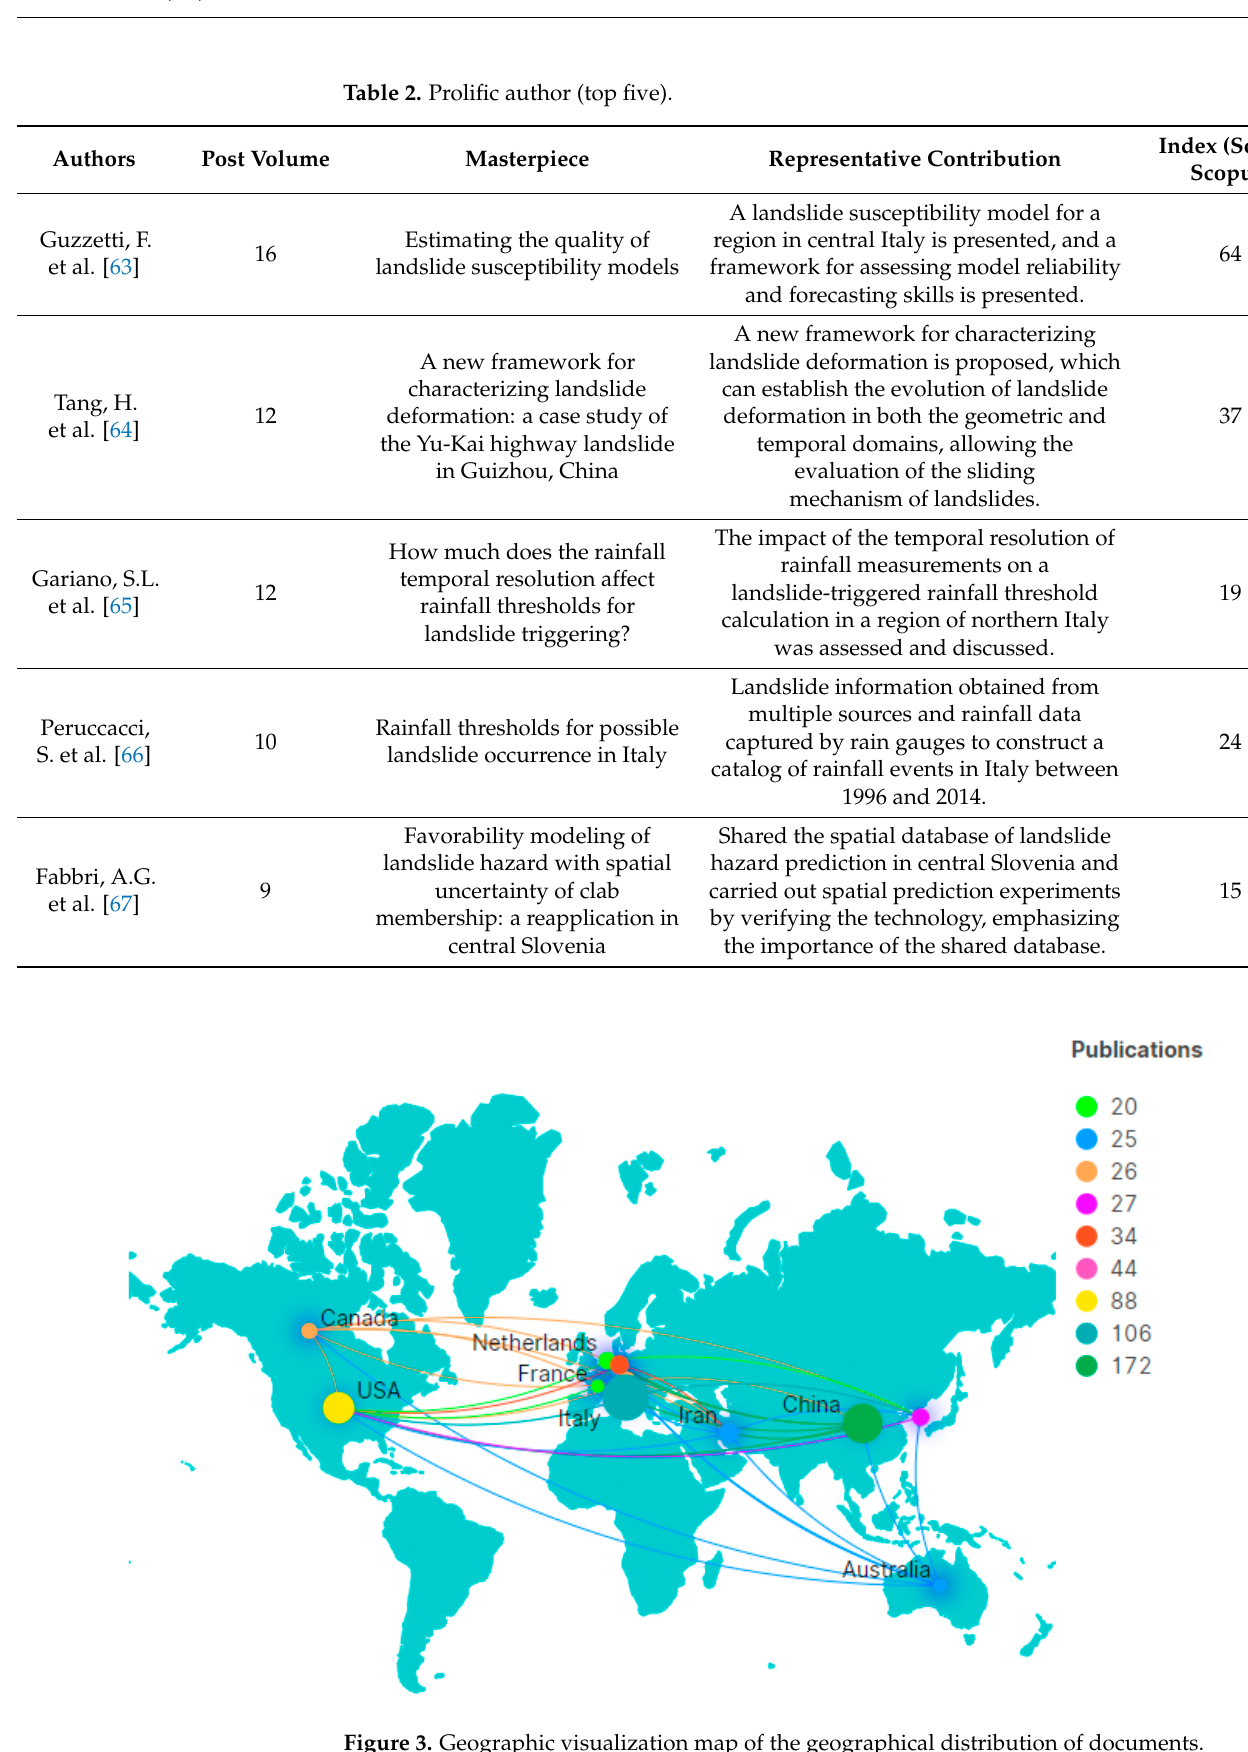
Figure 3. Geographic visualization map of the geographical distribution of documents.